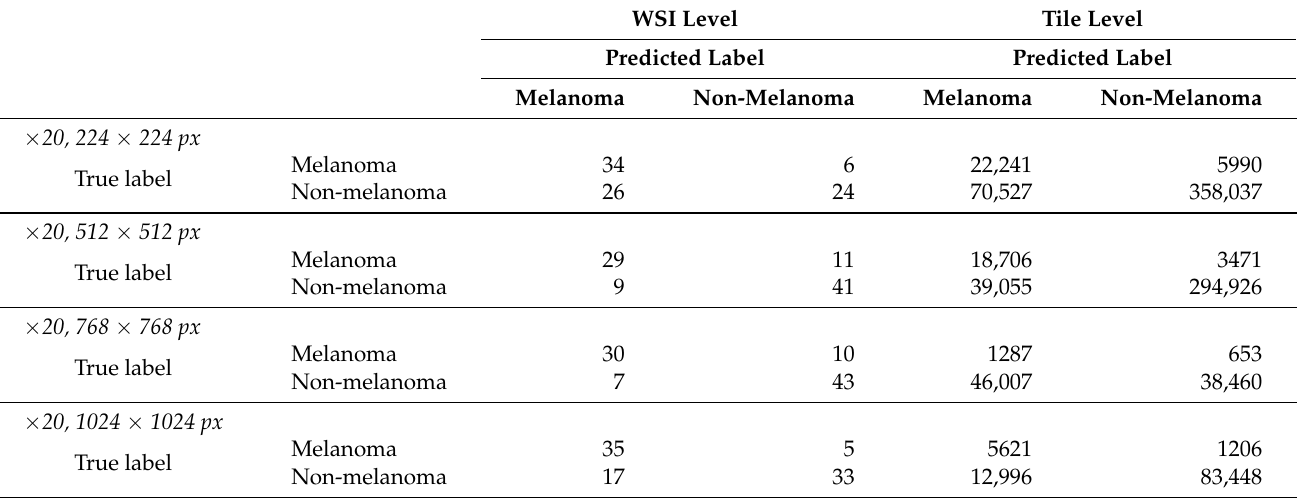
Table 5. Confusion matrix on both the WSI level and tile level. A cut-off threshold of 50% was used to convert the probabilities into